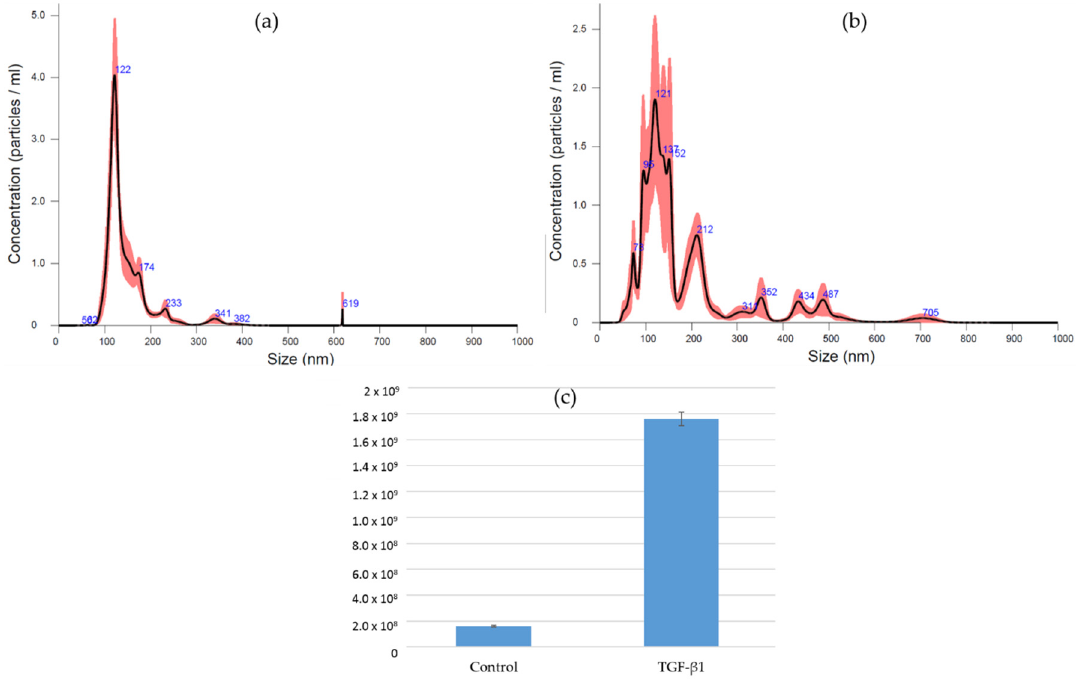
Figure 4. Purified EVs suspended in PBS were subjected to nanoparticle tracking analysis. ( a ) EVs purified from CM of control cells. ( b ) EVs purified from CM of TGF- β 1-treated cells. ( c ) Particle concentration of purified EVs from control and TGF- β 1-treated cells (dilution factor 1:25).